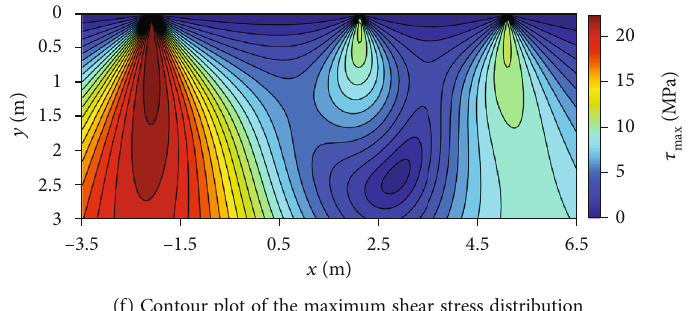
(f) Contour plot of the maximum shear stress distribution Figure 12: Characteristics of stress evolution along the surrounding rock of the empty roadway after cutting the roof.